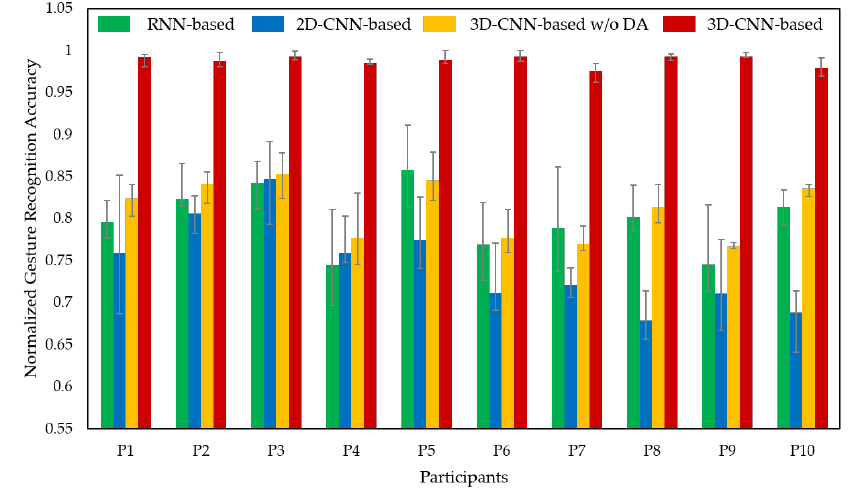
Figure 18. The gesture recognition accuracy of three system for new participants (target domain).